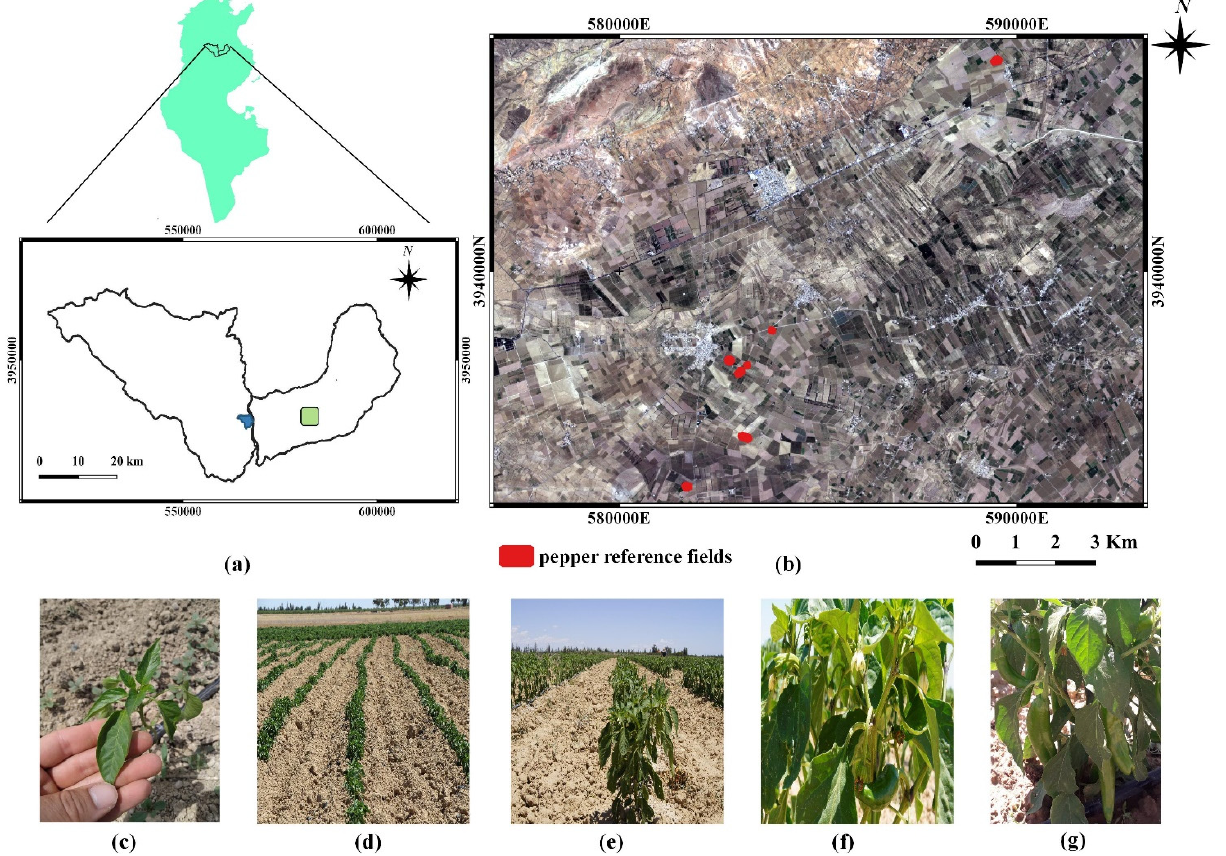
Figure 1. ( a ) Location of the study area in the Kairouan Plain at the center of Tunisia (red mark). ( b ) Reference pepper fields in the study area delimited by Sentinel-2 images in yellow. Photos of selected pepper growth stages in the reference fields ( c ) leaf development stage ( d ) pepper crop rows during leaf development stage ( e ) flowering stage ( f ) fruit development stage ( g ) fruit ripening stage.